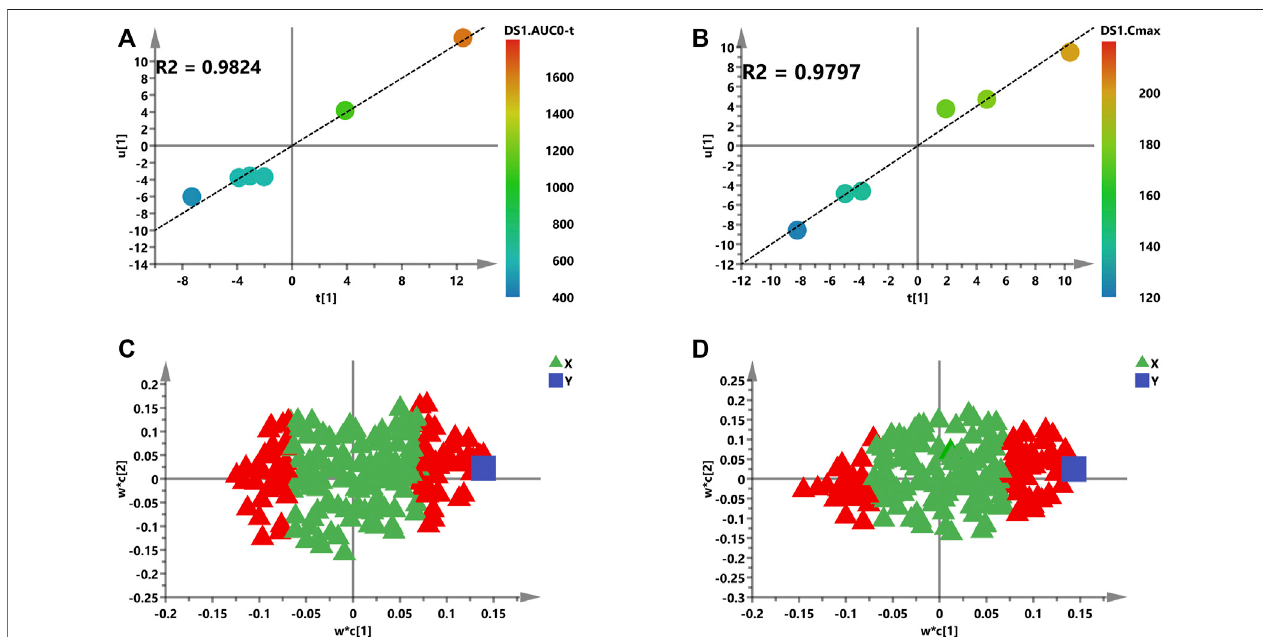
FIGURE 6 | Initial PLS models of the pre-dose metabolic pro fi le for predicting PK parameters of Nuc. (A) and (B) are score plots for the fi rst latent variable of the AUC and C max prediction model, respectively; each dot represents a rat, plotted as the fi rst latent variables ( X block) vs. AUC or C max ( Y block). A color from blue to red represents the response variable from low to high. (C) and (D) are loading plots for the AUC and C max prediction model, respectively. The blue box represents the response variable, each triangle represents a metabolite, and the triangles in red represent the metabolites with VIP > 1.0.